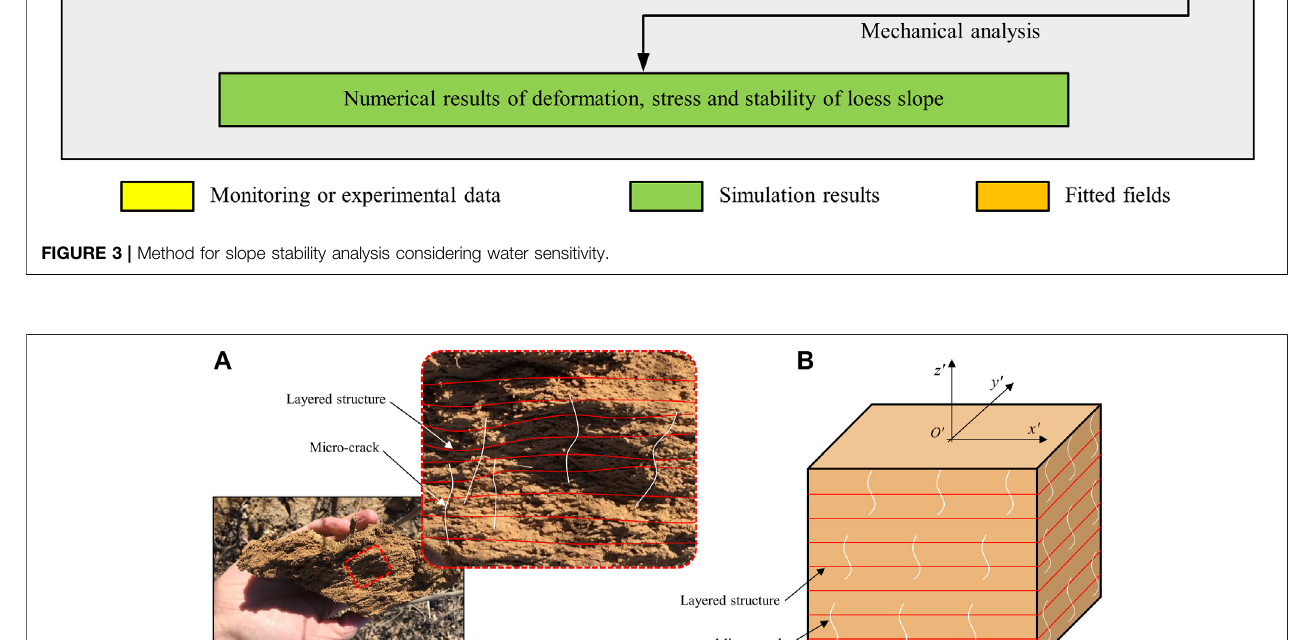
Frontiers in Earth Science |